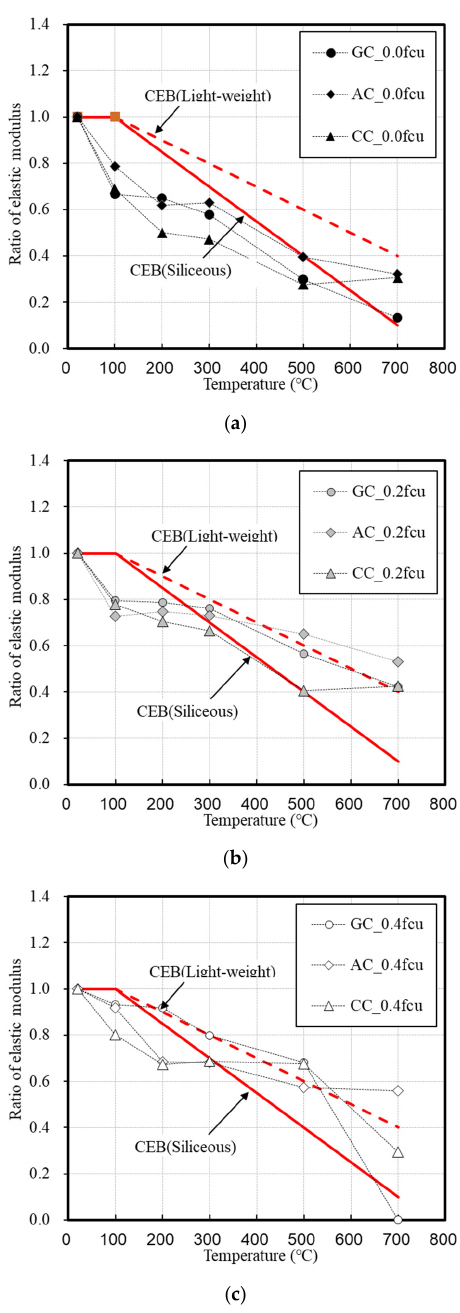
Figure 9. Comparison of experimental data with CEN and CEB codes on elastic modulus. ( a ) 0.0fcu loaded. ( b ) 0.2fcu loaded. ( c ) 0.4fcu loaded.